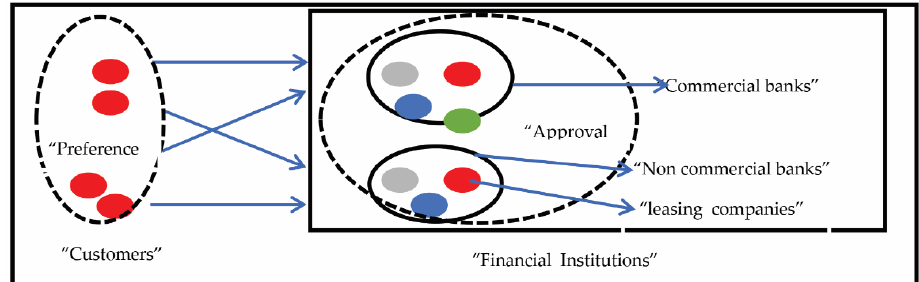
Figure 1. Preference and approval in financial institutions.